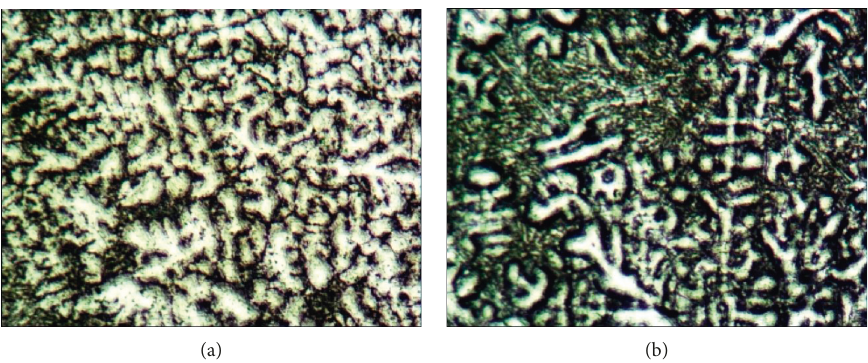
Figure 4: The optical microstructure of LM 25-B 4 Cnp-Grnp hybrid composites. (a) LM 25–5% B 4 Cnp-5% Grnp. (b) LM 25–10% B 4 Cnp- 10% Grnp.